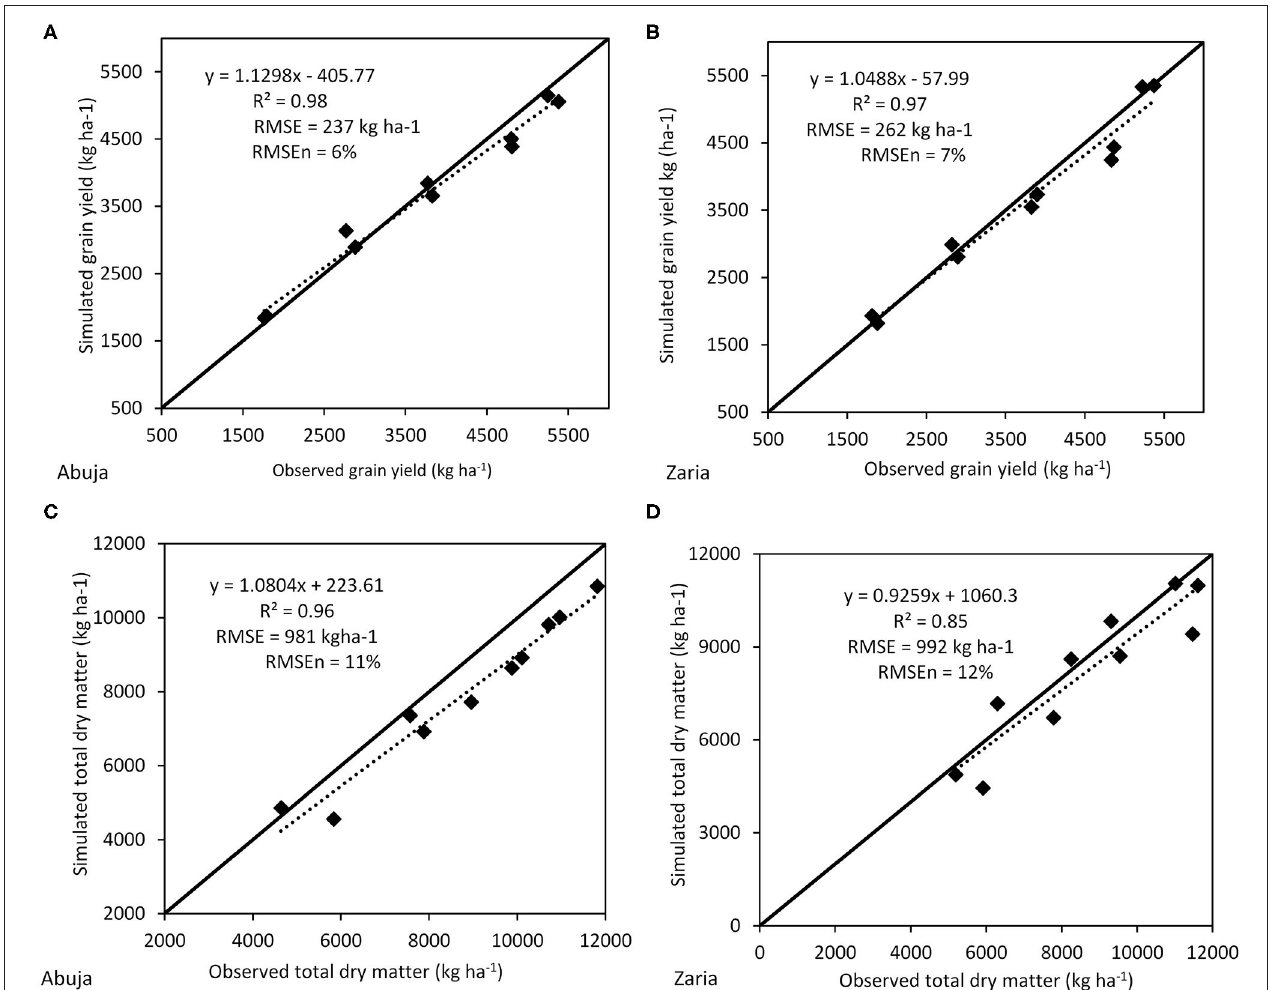
FIGURE 3 | (A–D) Comparison of observed and simulated outputs of model validation data for grain yield and total dry matter (TDM) at varying N-fertilizer applications for IWDC2SynF2 in Abuja and Zaria (each point is average of treatment during 2016 and 2017 cropping seasons).